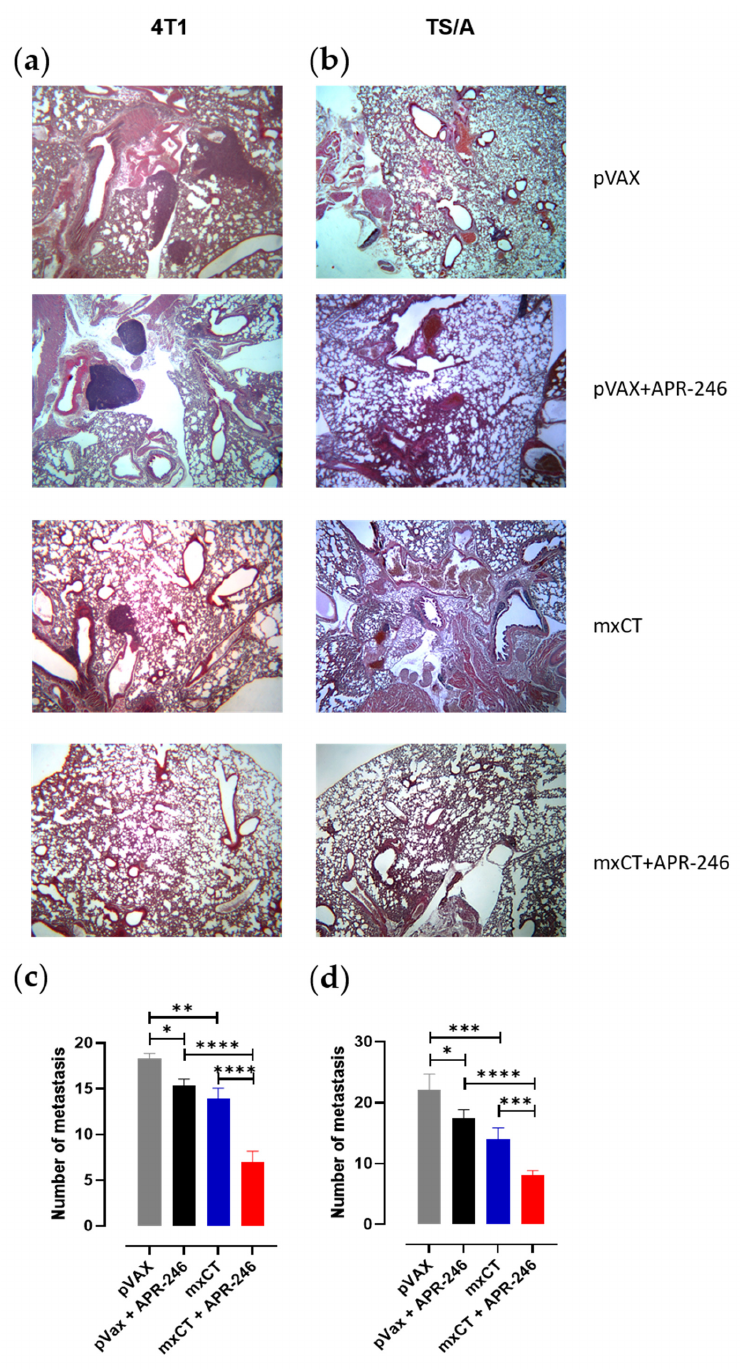
Figure 5. Effect of APR-246 and anti-xCT immunization on lung metastases formation. Histology of spontaneous lung metastases in BALB/c mice challenged s.c. with ( a ) 4T1 or ( b ) TS/A and treated with APR-246 in combination with the electroporation of pVAX control plasmid or of mxCT plas- mid. The lungs were collected at the experimental endpoint and formalin-fixed, paraffin-embedded sections were processed for H&E staining; representative pictures are shown (Olympus BX41 micro- scope; 2.5 × magnification). Lung metastases of ( c ) 4T1- or ( d ) TS/A-bearing mice that underwent the different treatments have been quantified; histograms represent the mean value ± SEM of the number of metastases manually counted with a Nikon SMZ1000 stereomicroscope in two slices per sample obtained from the different groups of mice. * p ≤ 0.04; ** p = 0.004; *** p = 0.0002; **** p < 0.0001; Student’s t